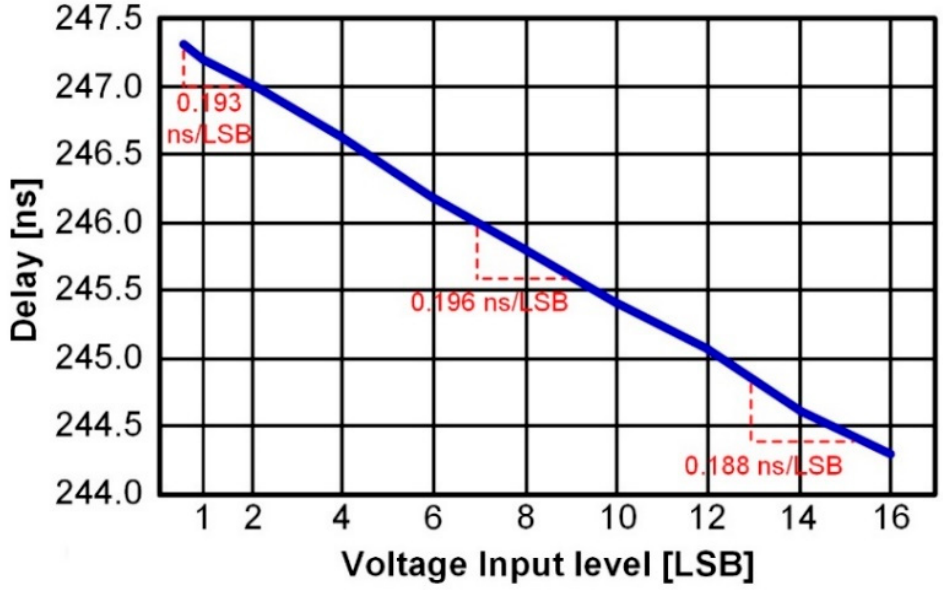
Figure 6. Voltage-To-Time performance of VCDL.